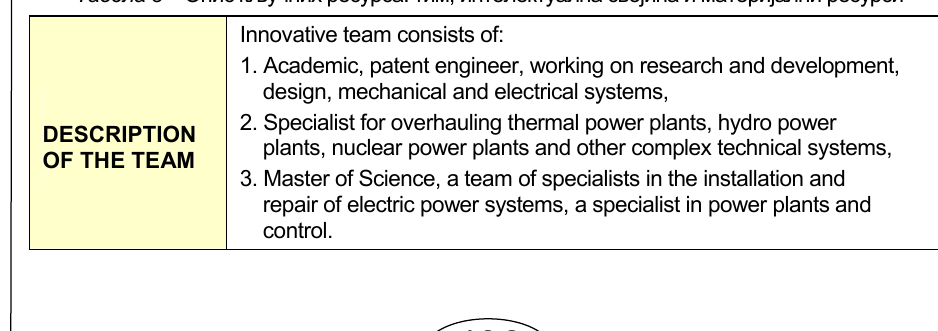
Table 3 – Description of the key resources: Team, intellectual property and material resources Таблица 3 – Описание основных ресурсов : Команда , интеллектуальная собственность